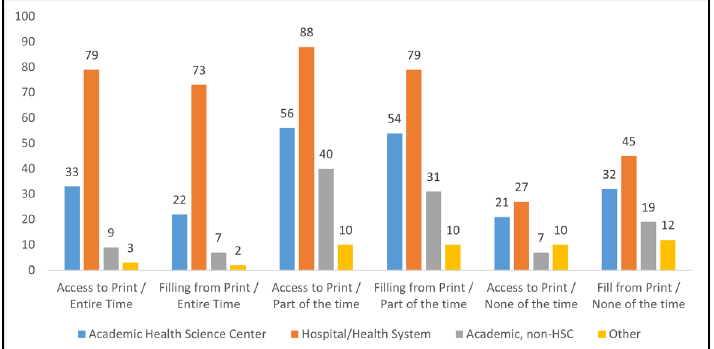
Figure 3 Print Collection Access (N=429) and Print ILL Participation (N=430) by Type of Library.